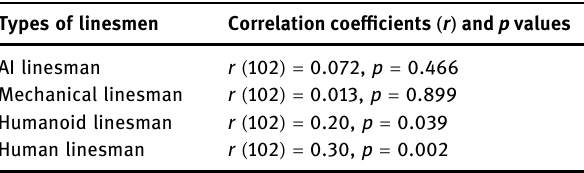
Table 3: Results of Spearman ’ s correlation tests for “ Trust ” and “ Preference